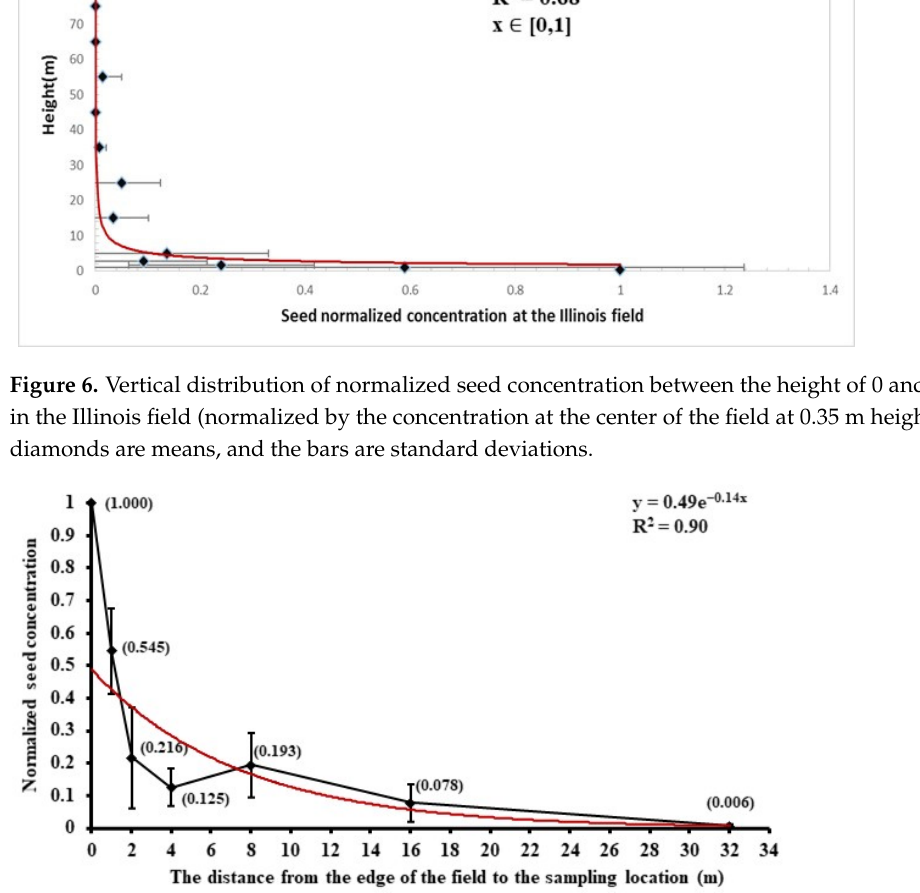
Figure 7. Horizontal dispersion of normalized seed concentration in the Tennessee field (normalized by the concentration at the distance of 0 m from the edge of the field) along the downwind direction, and all the collecting rotorod samplers were set up at the height of 0.5 m. The diamonds are means and bars are standard deviations.